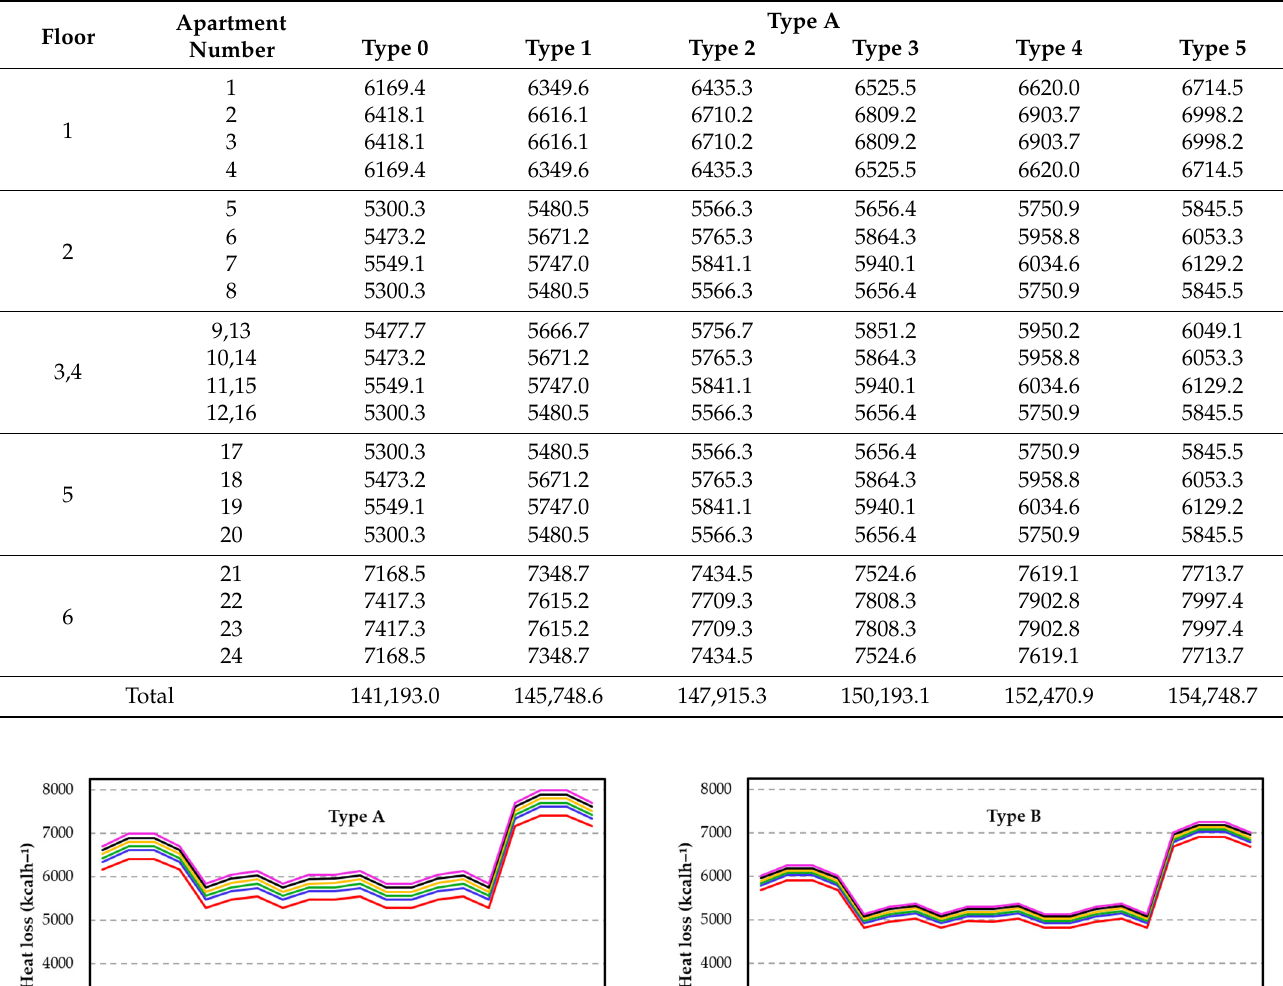
Table 6. Head loss values of Type A according to building types (Erzurum).